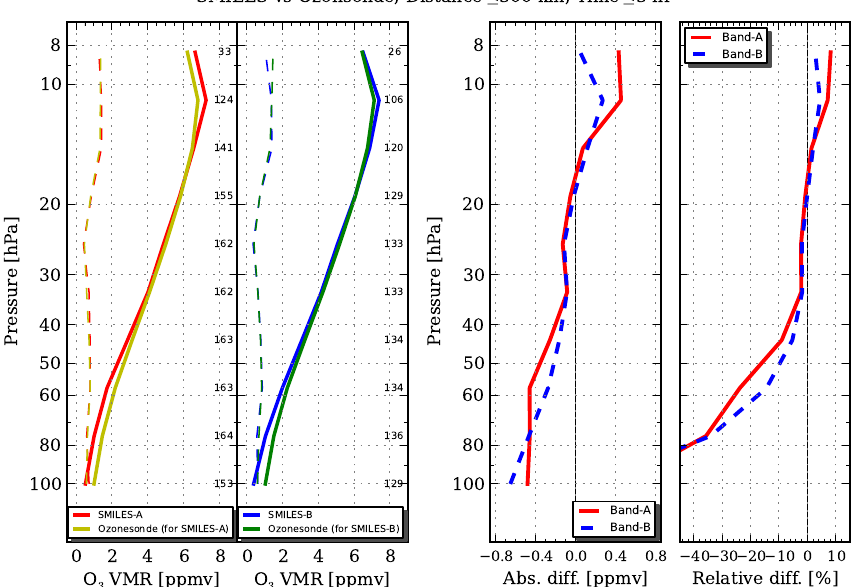
Fig. 11. Ozonesonde stations where coincidences were found in this study. Magenta dots are observation points where coincidences were found between ozonesondes and both Band-A and Band-B, respectively. Red dots are those where comparisons were between ozonesondes and Band-A. Blue dots are those for the comparison between ozonesondes and Band-B.